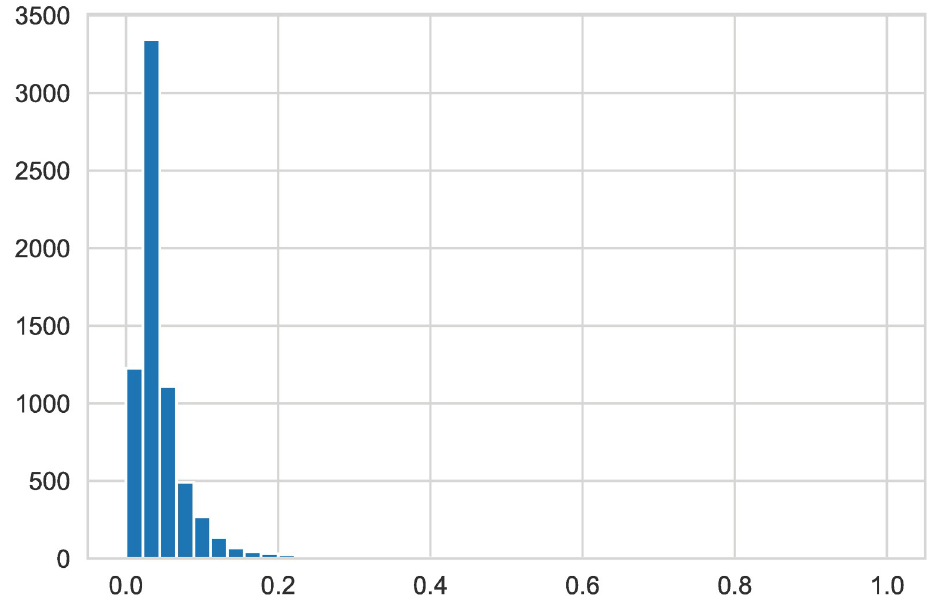
Fig 4. ’Equity to Liability’. The histogram of this attribute value is skewed to some extent.